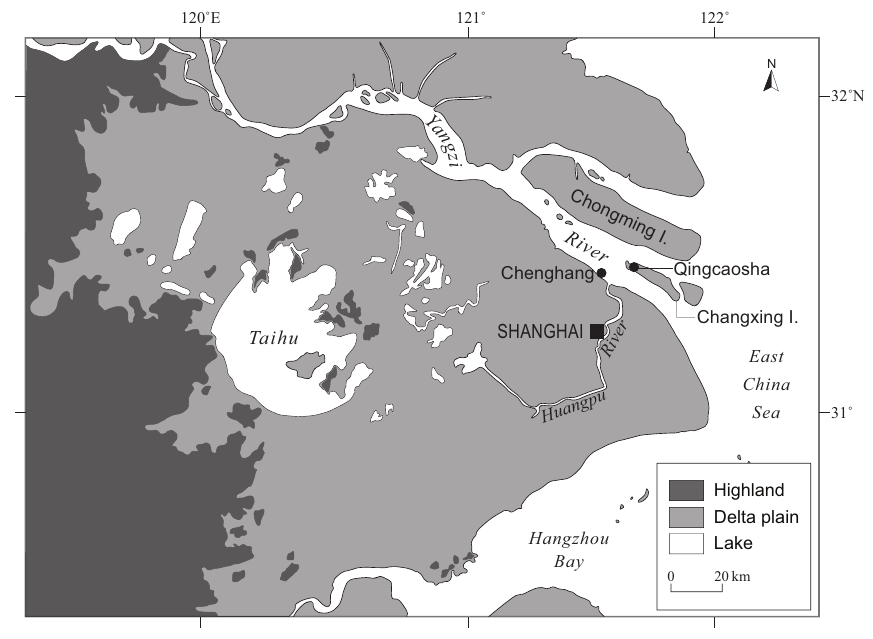
Figure 1. Map of Yangtze